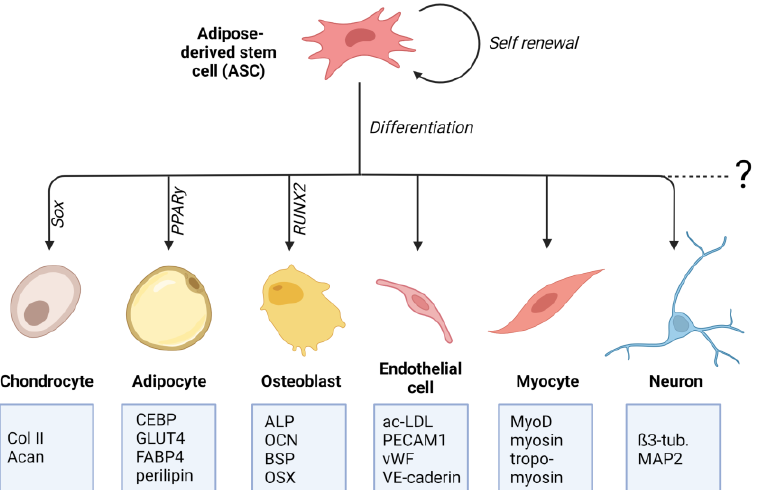
Figure 1. Differentiation potential of adipose-derived stem cells (ASCs): ASCs are multipotent mesenchymal stem cells that can be isolated from adipose tissue. ASCs can differentiate into mesenchymal cell lines such as osteocytes, adipocytes, and chondrocytes. There is also evidence for their differentiating potential into non-mesenchymal cell lines, such as endothelial cells, neuronal cells, and cardiac and skeletal myocytes. For each differentiation lineage, a specific “master transcriptional regulator” is identified. For adipogenic lineage it is PPARγ, for osteogenic lineage it is RUNX2, and for chondrogenic lineage it is Sox9. Lineage-specific differentiation can be determined by specific proteins that are listed in the boxes (created with BioRender.com).